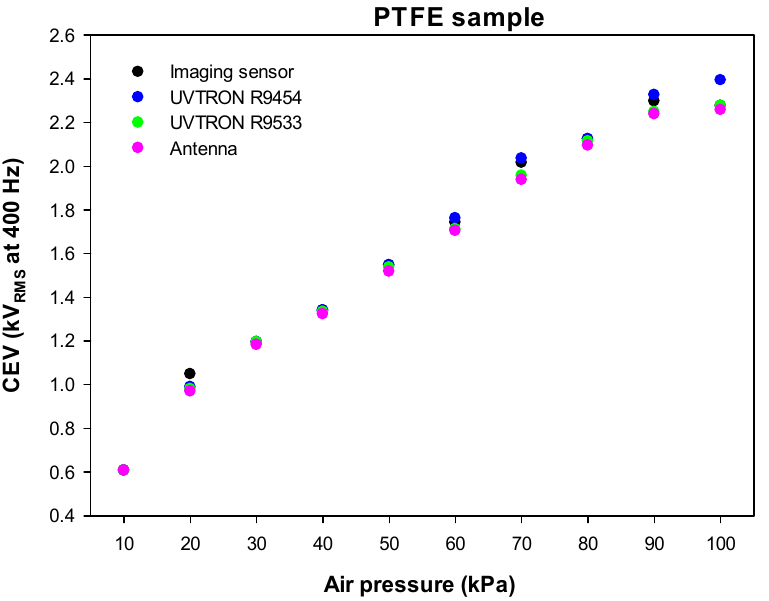
Figure 5. Results attained with the different sensors in the 10–100 kPa range covering the pressure range found in aeronautic applications using the PTFE-insulated wire electrodes depicted in Figure 2.